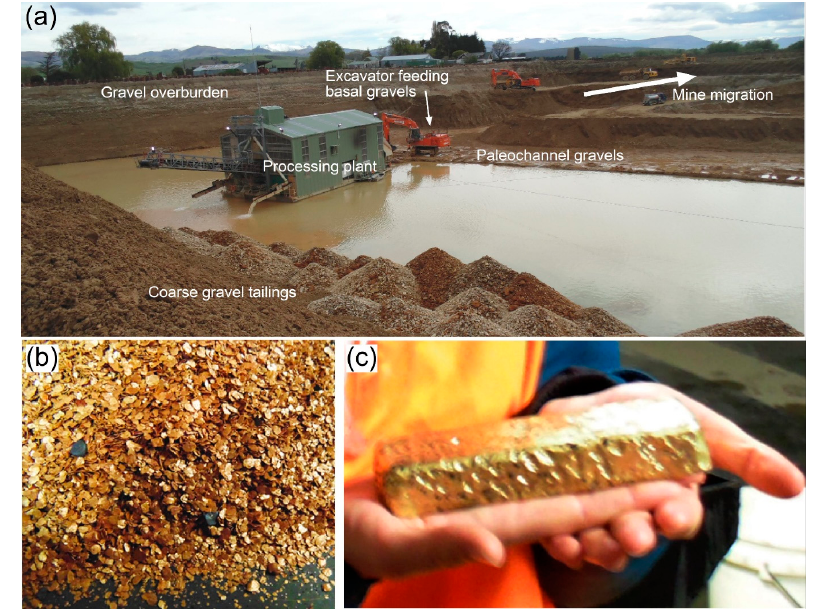
Figure 2. Mining processes and products at the Waikaia placer gold mine. ( a ) Active mine excavation and processing site; ( b ) Gold concentrate, dominated by flakes ~0.5–1 mm across; ( c ) Doré bar produced from the gold concentrate.